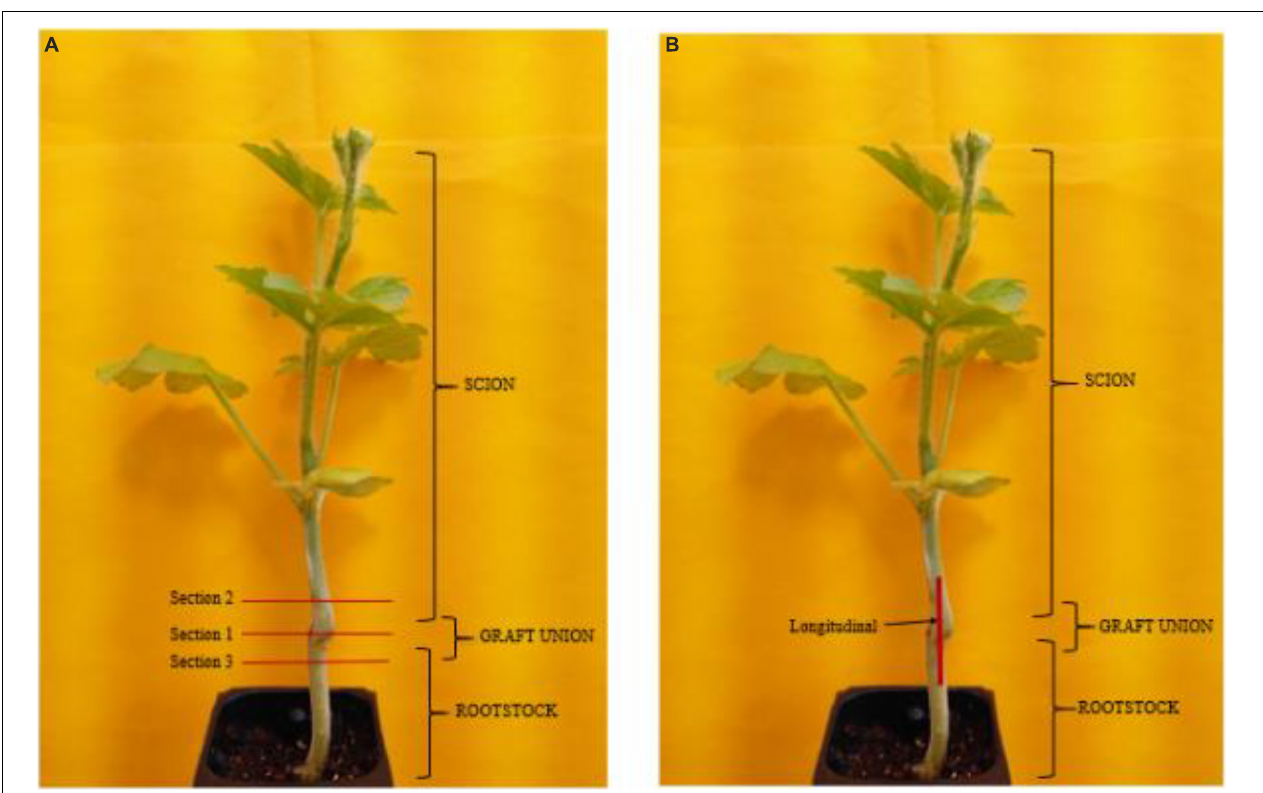
FIGURE 1 | Transverse (A) and perpendicular (B) hypocotyl samples of watermelon cultivar ‘Secretariat’ grafted on rootstock cultivar ‘Tetsukabuto’.